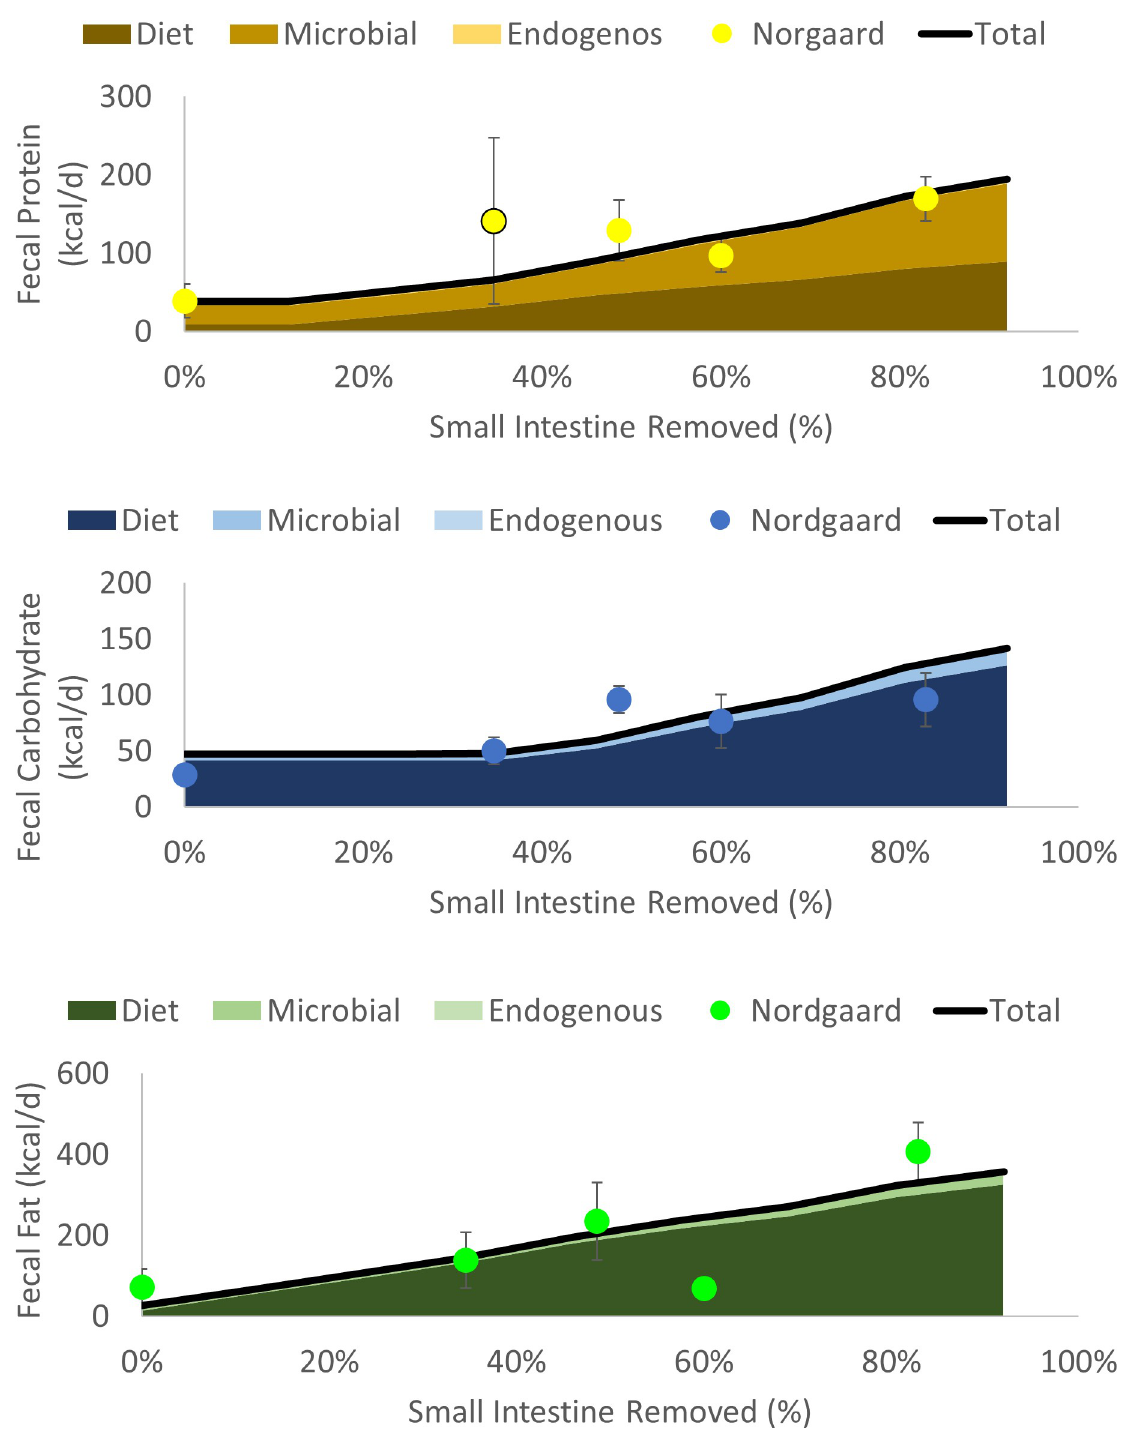
Fig 3. The effect of varying degrees of small-intestine resection on fecal content leaving the colon after digestion by the colonic microbiota. Model estimates of dietary, microbial, and endogenous secretions of macronutrients are shown as shaded areas, and their total are shown as the solid lines. The clinical data from Nordgaard et al. [15] are shown as points.